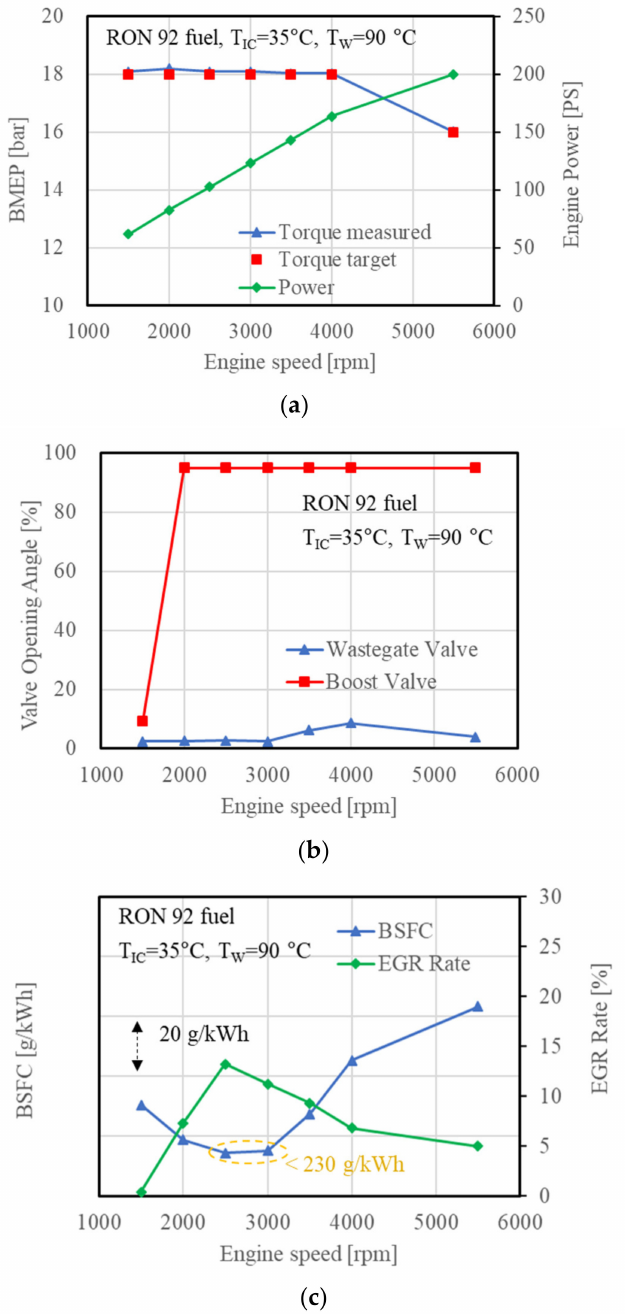
Figure 11. ( a ) Full load performance; ( b ) exhaust control valves operation; ( c ) BSFC and EGR